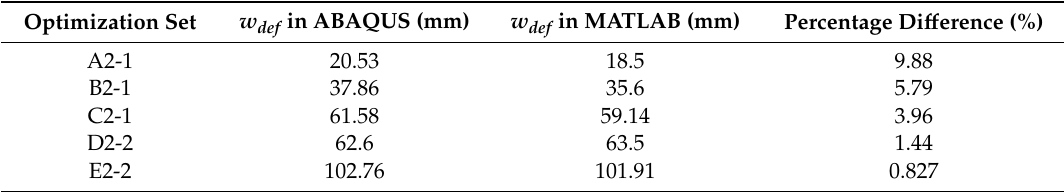
Table 8. Comparison of w def obtained from ABAQUS’s model based on the optimal design parameters Table 7. Comparison of 𝑤 (cid:3031)(cid:3032)(cid:3033) obtained from ABAQUS’s model based on the optimal design for the search space given by ϕ 1 = 75 ◦ , ϕ 2 = 0 ◦ . parameters for the search space given by φ (cid:2869) = 45°, φ (cid:2870) = 0°. Optimization Set w def in ABAQUS (mm) w def in MATLAB Optimization Set